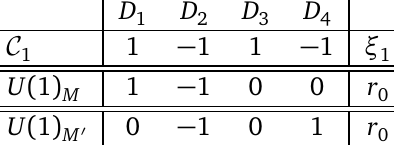
= 2 phases such as (q), (n), f